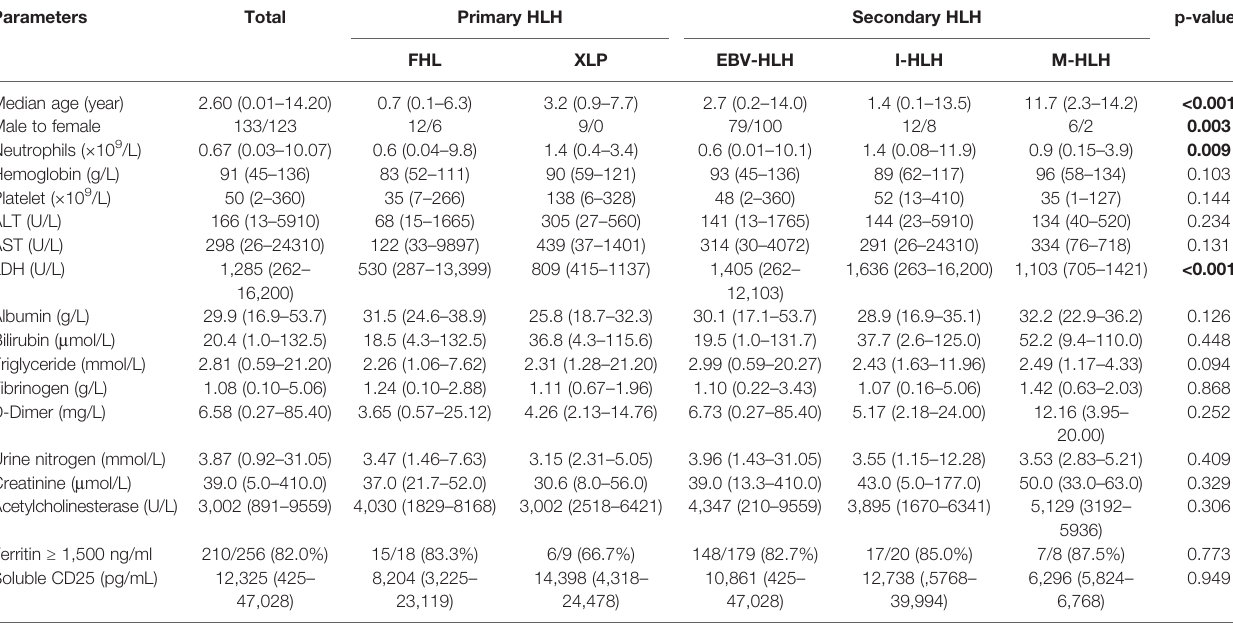
TABLE 1 | Comparison of clinical characteristics and laboratory fi ndings among patients with different subtypes of HLH (median and range).